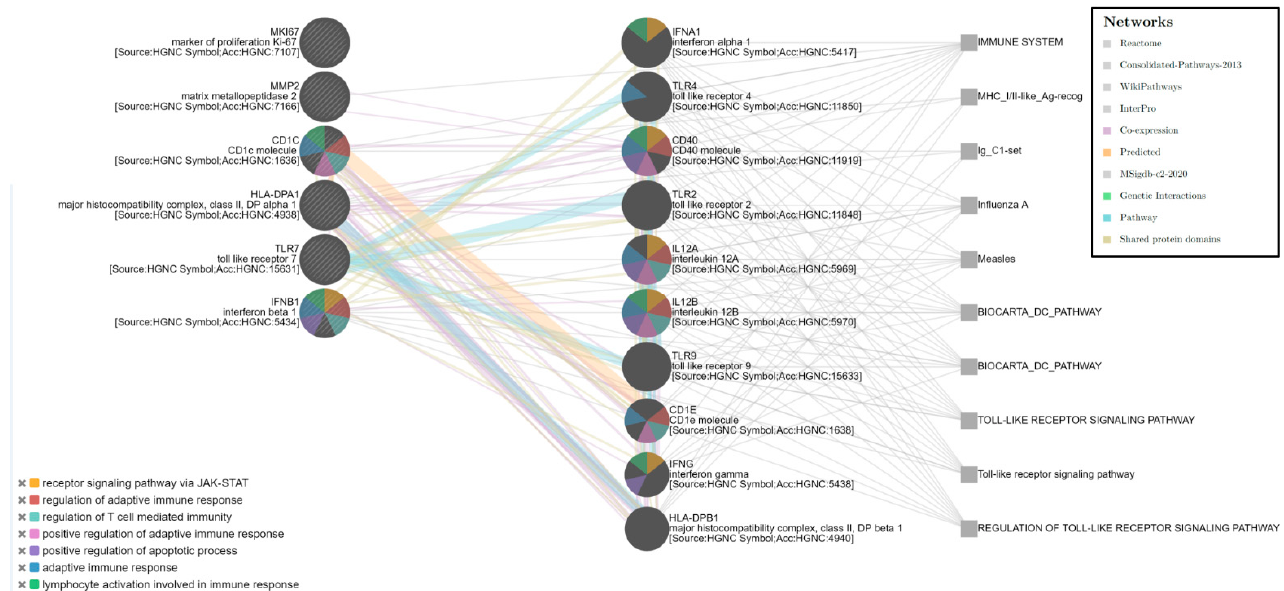
Figure 4. Gene correlation network by the Bayesian computational analysis